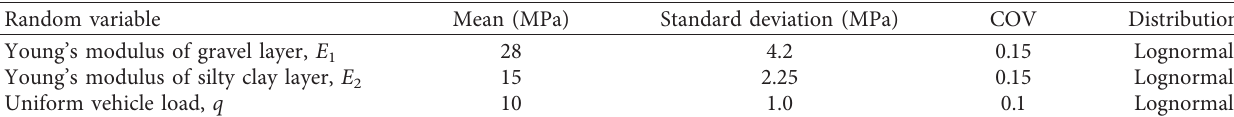
Table 3: Prior statistics of three random